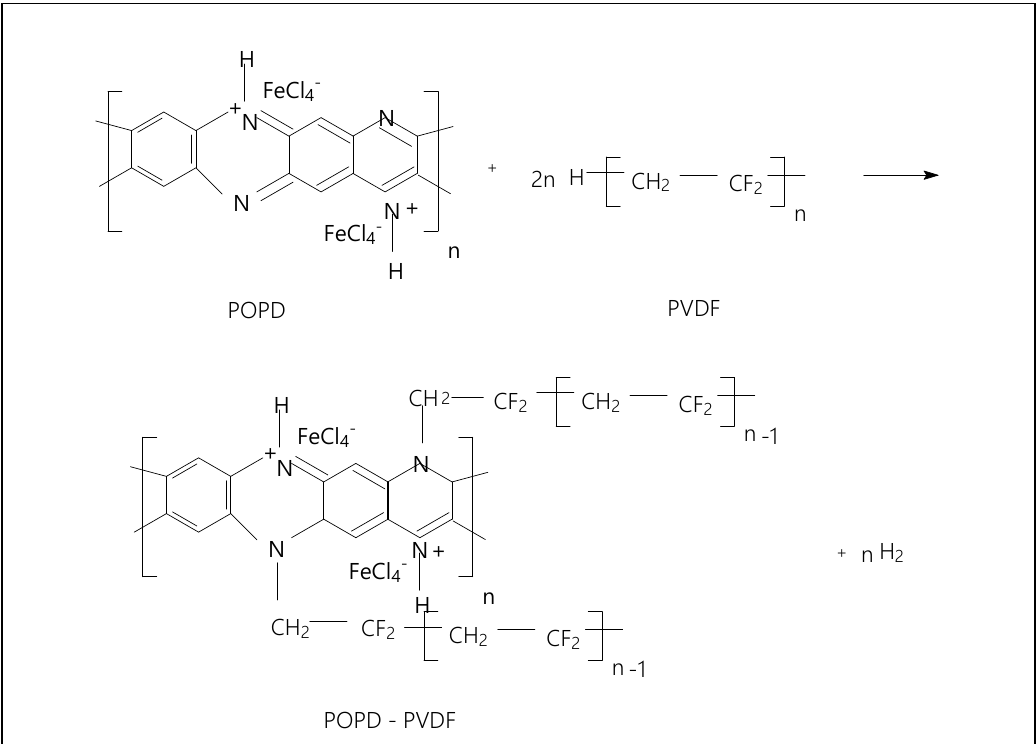
Scheme 1. The chemical reaction of POPD doped with FeCl 4- ions with PVDF.